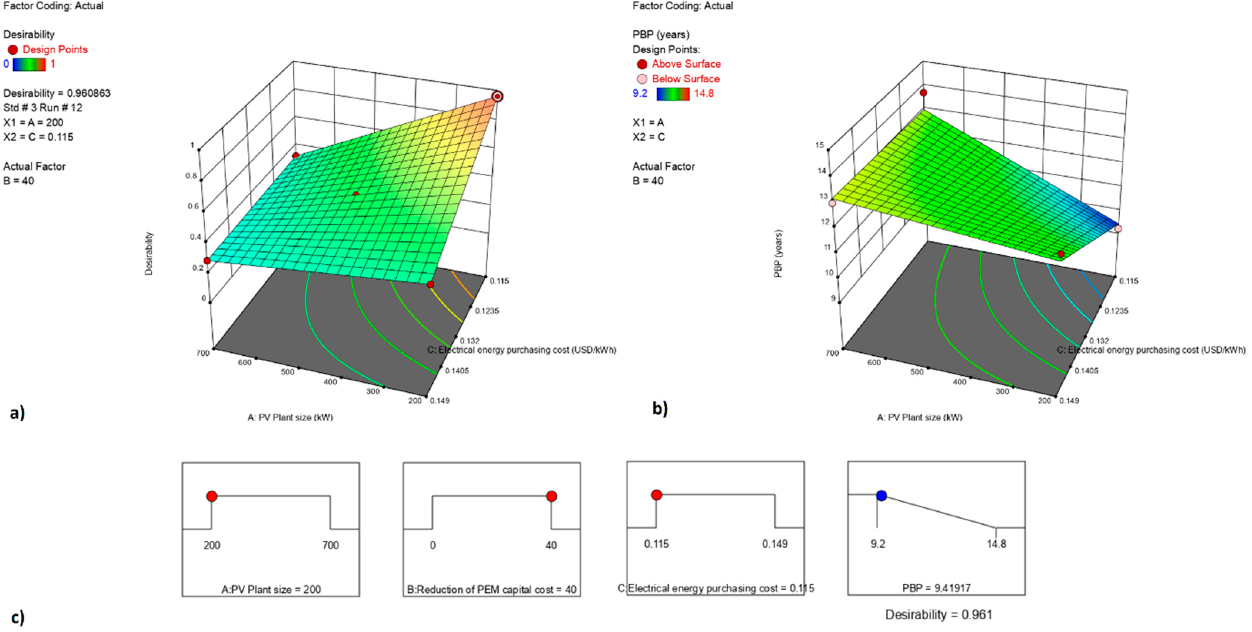
Figure 9. Desirability function plots. ( a ) Response surface plot of overall desirability function. ( b ) PBP response surface plot associated with the desirability function. ( c ) Desirability ramp for achieving optimum PBP.